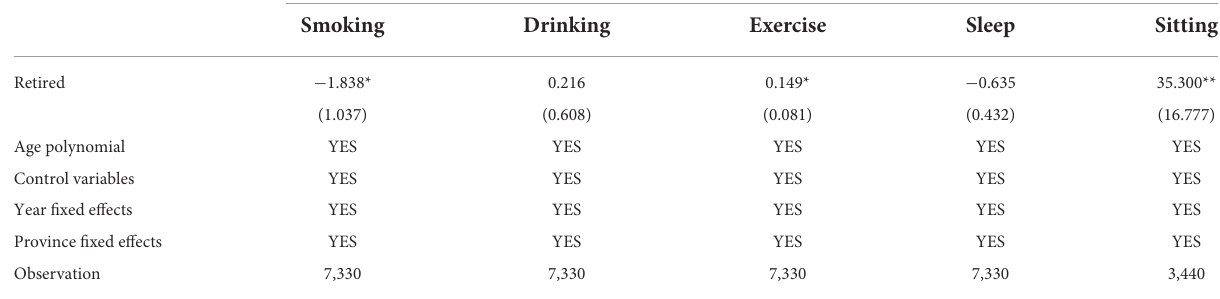
TABLE 7 Results of using other dependent variables.